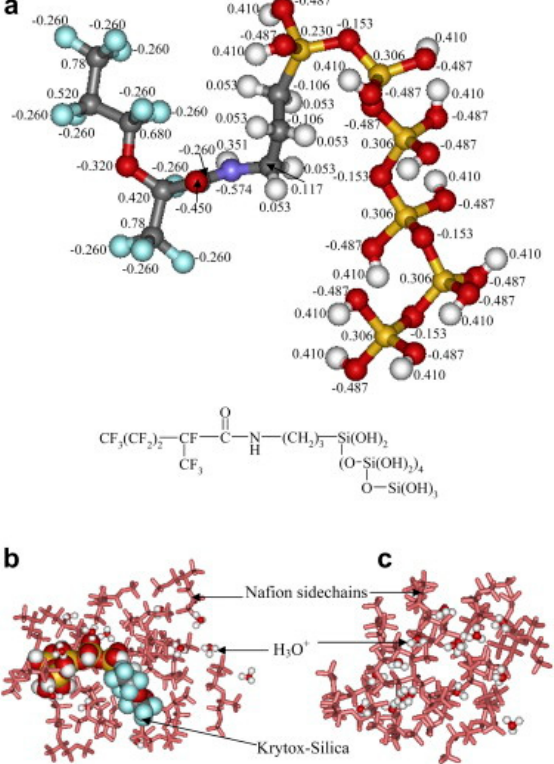
Figure 4. Initial structures of ( a ) Krytox-Silica molecule and charges, ( b ) 5% wt of Krytox-Silica in Nafion system, and ( c ) pure Nafion system [89].